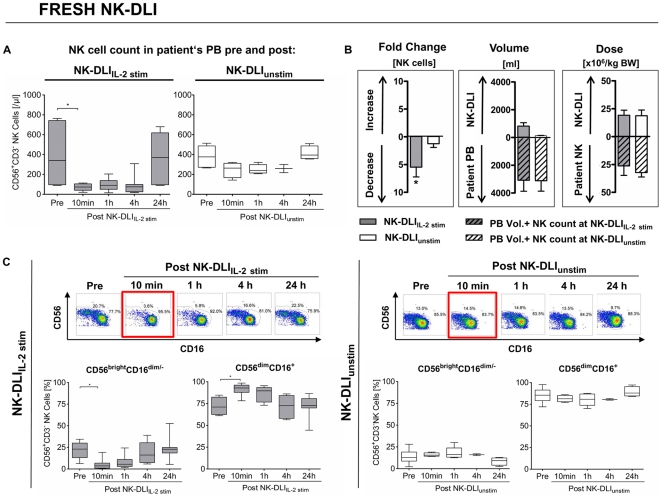
NK-DLIIL-2 stim but not NK-DLIunstim led to a considerable disappearance of NK cells from PB.A) Absolute number of NK cells in the PB of the patients was significantly reduced 10 min post NK-DLIIL-2 stim (grey) in contrast to NK-DLIunstim (white), which showed minimal influence only. 24 h after NK-DLIIL-2 stim absolute number of NK cells recovered to the level before DLI. Only freshly applied NK-DLIs infused around day +40 post SCT are shown and were used for statistical calculations (n = 7 NK-DLIIL-2 stim, n = 6 NK-DLIunstim). Box and whiskers plots show minimum, lower quartile, median, upper quartile and maximum of all measured data. For the 4 h level post NK-DLIunstim two values were available, only. p<0.05 indicated as *. B) Mean and SEM of all freshly applied NK-DLIIL-2 stim (grey) and NK-DLIunstim (white) applied around day +40 post SCT. Striped bars indicate estimated patient's PB volume and peripheral NK cell count at the time point of NK-DLI infusion. Left graph shows a mean 5.5-fold reduction of absolute NK cell count in the PB as early as 10 min post NK-DLIIL-2 stim compared to a 1.2-fold decrease for NK-DLIunstim. Middle graph shows relation of NK-DLI volume to total blood volume of patients (NK-DLIIL-2 stim volume: 825 ml±249, compared to PB volume: 3060 ml±789; NK-DLIunstim volume: 128 ml±19, compared to PB volume 3093 ml±749). DLI volume did not artificially lead to the reduced absolute NK cell count, since NK-DLIIL-2 stim volumes made up maximally around ¼ of patient's PB volume. Right graph shows mean NK-DLI cell dose ×106/kg BW (NK-DLIIL-2 stim 19.2±4.5; NK-DLIunstim 18.8±5.1) in relation to patient's PB NK cells newly reconstituted post haplo-SCT around d +40 prior to NK-DLI (NK-DLIIL-2 stim 26.0±8.5; NK-DLIunstim 31.9±4.0). Applied NK dose compromised about 80% of PB NK cells, illustrating the high dose of administered NK-DLI. C) Density plots (CD56 vs. CD16) and box and whiskers plots show a significant change in the distribution of the cytotoxic CD56dimCD16+ and immune regulatory CD56brightCD16dim/− NK cell subsets. This was due to an absolute reduction of the CD56brightCD16dim/− NK cell subpopulation in the PB 10 min after freshly applied NK-DLIIL-2 stim applications infused around d +40 (left; n = 7). This could not be shown after NK-DLIunstim (right; n = 6). Plots are gated on CD56+CD3− NK cells. For the 4 h level post NK-DLIunstim 2 values were available, only. p<0.05 indicated as *.